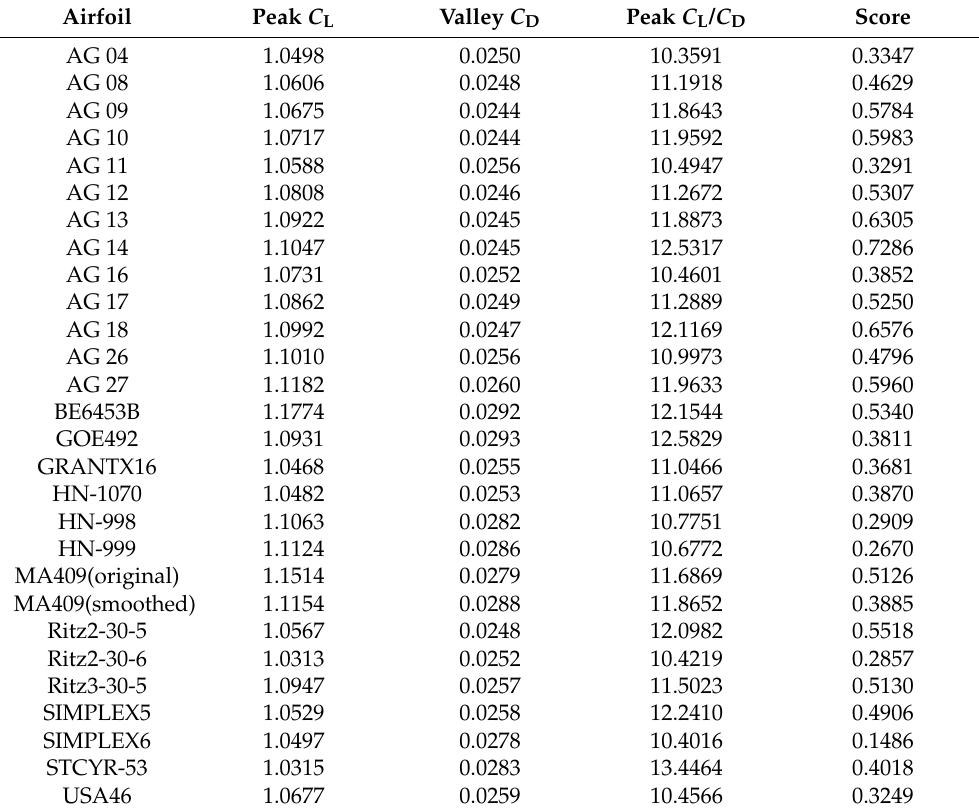
Table 1. The peak C L, the valley C D , the peak C L /C D and the final scores of the 28 selected airfoils.